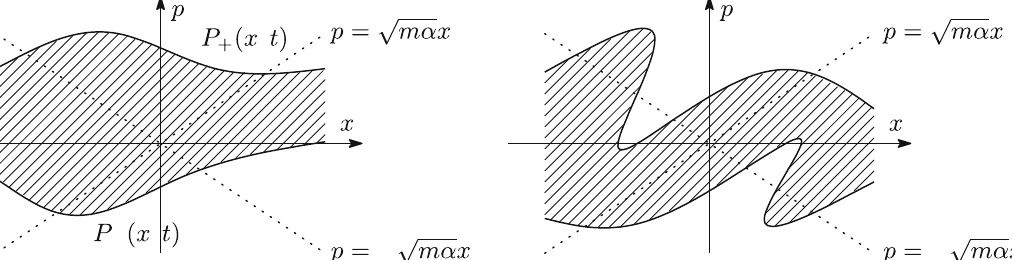
supersonic region ( x > 0) cannot propagate into the subsonic region ( x < 0). b Black hole (left): x → − x of the black hole (right). c White hole (right): The phonons in the subsonic region ( x < 0) cannot propa- gate to the supersonic region ( x > 0). d White hole (left): x → − x of the white hole